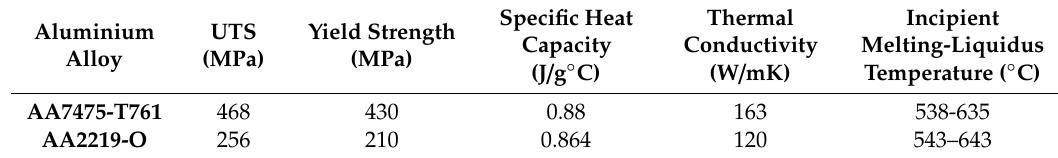
Table 3. Mechanical and thermal properties of AA2219-O and AA7475-T761